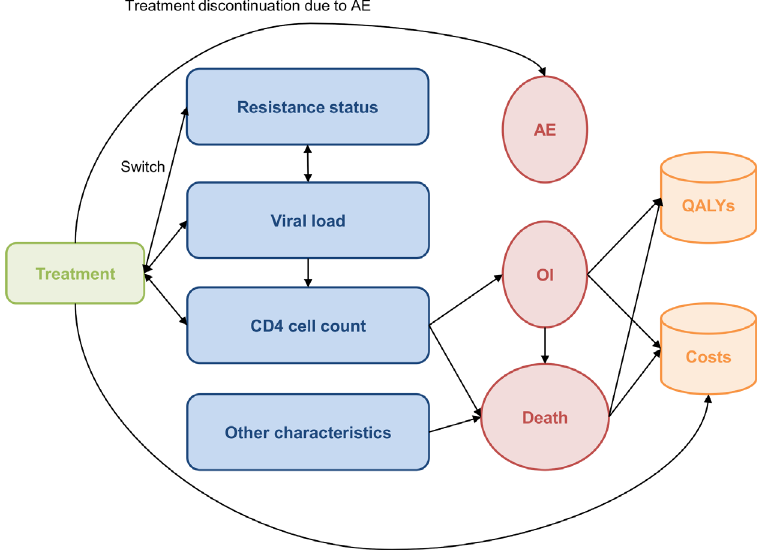
Fig 2. Influence diagram. AE: Adverse event; HIV: Human Immunodeficiency Virus; OI: Opportunistic Infection; QALYs: Quality Adjusted Life Years.